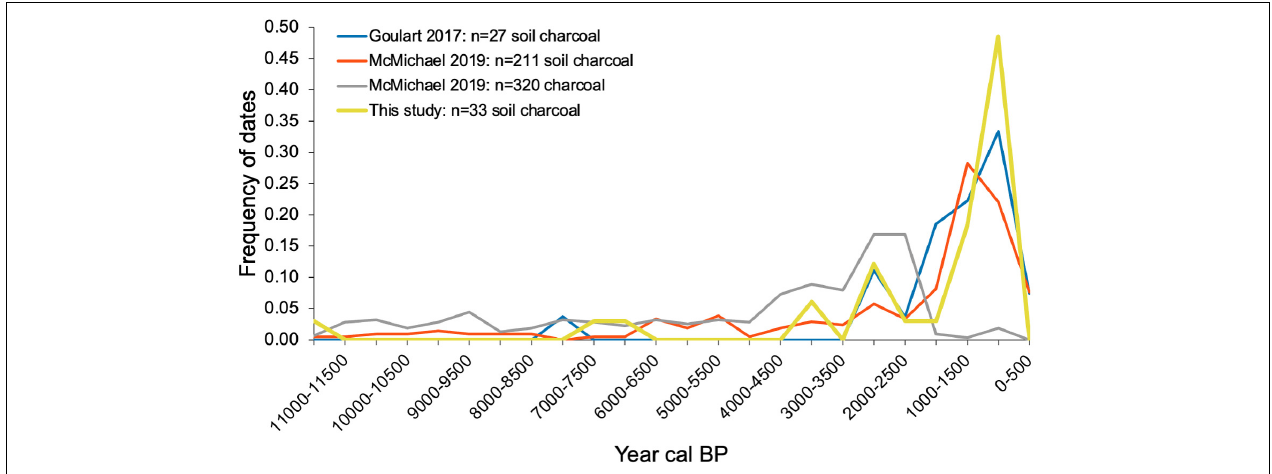
FIGURE 5 | Frequency of dates from charcoal and soil charcoal by years calibrated before present (BP) in fraction of total dates per study from Goulart et al. (2017), compilations by McMichael and Bush, 2019, and this